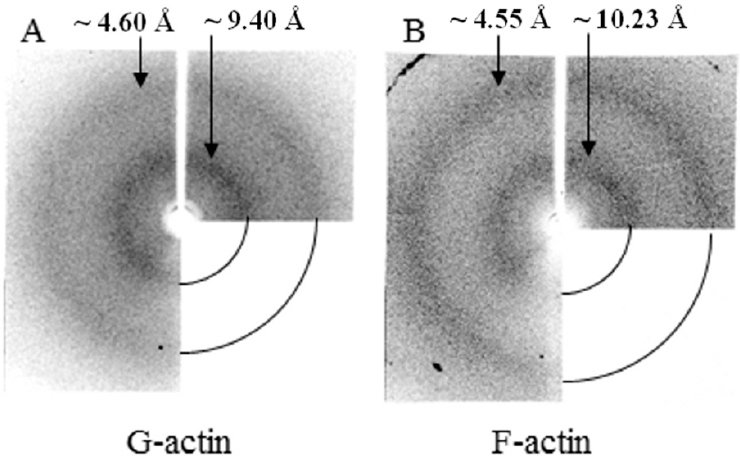
Figure 9. X ‐ ray diffraction pictures of G ‐ ( A ) and F ‐ actin ( B ).